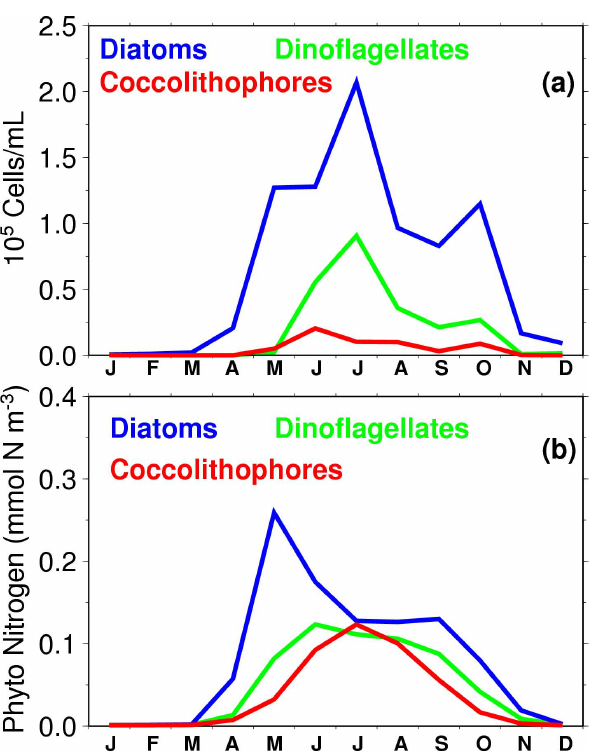
Fig. 11. Seasonal cycles of in situ CPR cell counts for diatoms, dinoflagellates, and coccolithophores (a) , and model nitrogen-based concentrations of the same functional groups (b) .